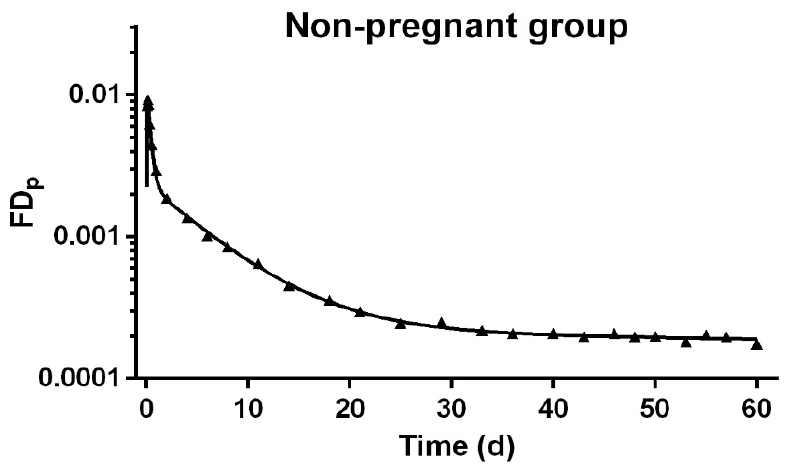
Figure 3. Fraction of administrated dose in plasma (FDp) versus time (d) after oral delivery of 3 H- labeled retinol in non-pregnant rats. Solid triangles are observed data presented as group geometric mean, n = 4; the line represents the model-predicted value.